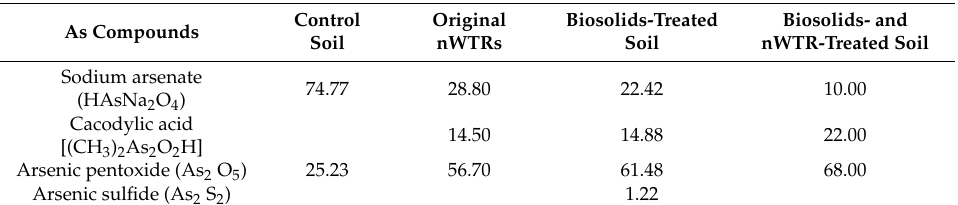
Table 4. Speciation fraction (%) of arsenic (As) in the soils that were treated with biosolids (3%) and